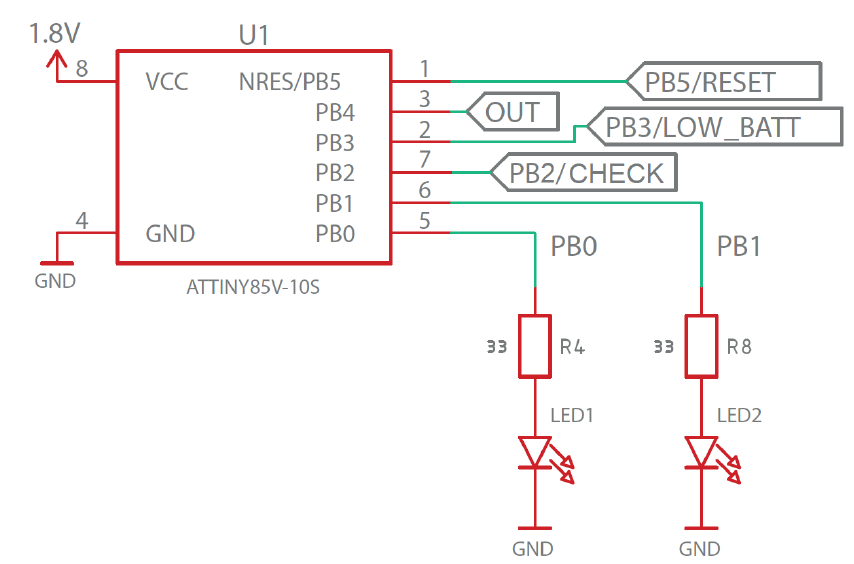
Figure 7. Control stage schematic